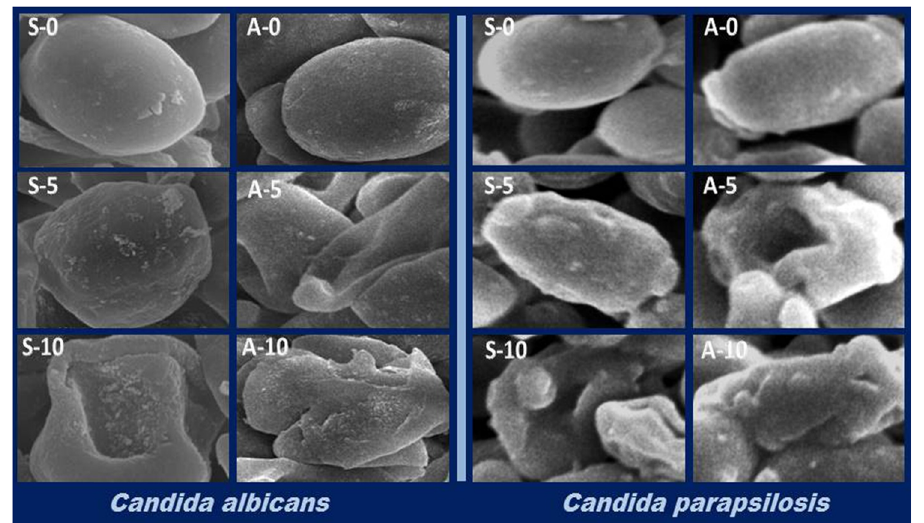
Figure 4: Consequences of exposing Candida sp. ( C. albicans and C. parapsilosis ) to Fu/Se - NPs ( S ) and Fu/Ag - NPs ( A ) on morphological attributes of cells after exposure for 0, 5, and 10